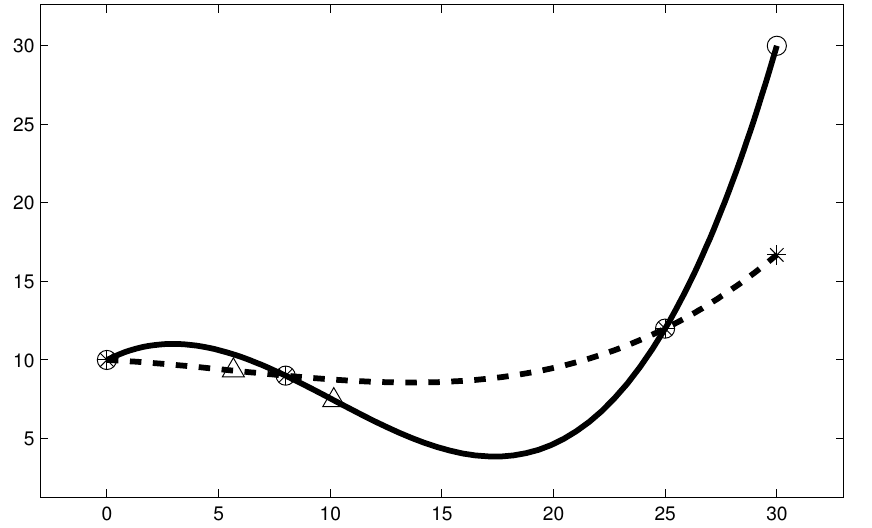
Figure 1. Solid line: Lagrange polynomial; dashed line: piecewise polynomial harmonic (PPH) polynomial. Circles stand for Lagrange values at the nodes, asterisks stand for PPH values at the nodes, and triangles stand for inflection